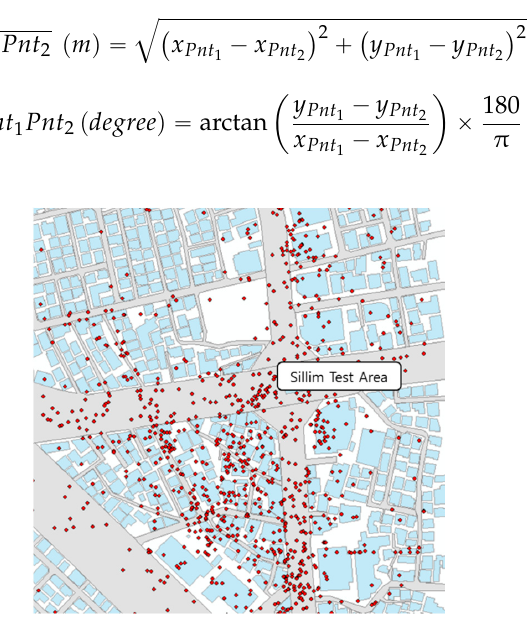
Figure 1. Venue distribution in Sillim test area.